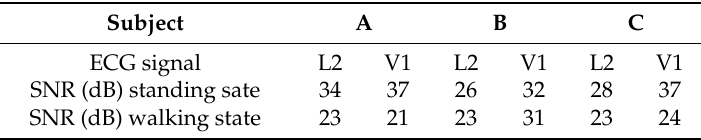
Table 3. SNR of ECG signals recorded with smartphone.